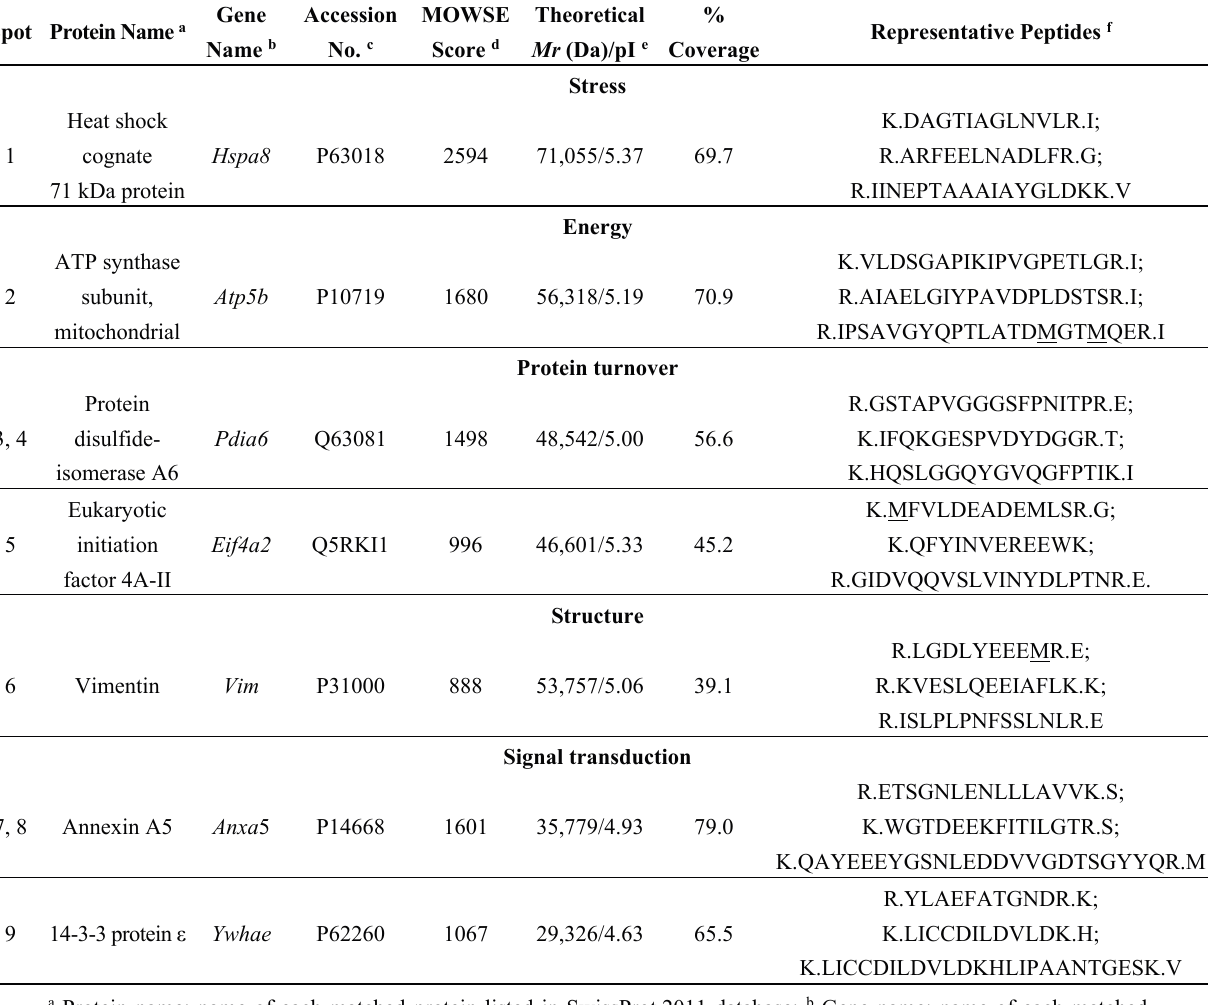
Table 1. Identities of the down-regulated proteins in DPCs treated by 2 µM CLC for 6 h.